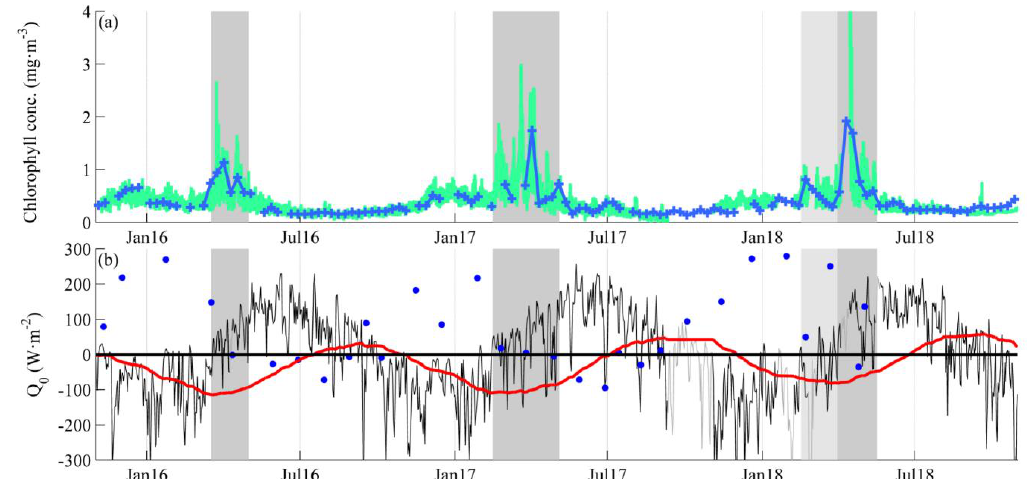
Figure 5. ( a ) Surface chlorophyll concentration derived from AGL buoy hourly fluorescence measurements at 3 m depth (green line) and from weekly satellite-derived Chlorophyll a concentration from GlobColour project (blue cross line). ( b ) Net heat flux (Q 0 ) (black line) from the ocean to the atmosphere (negative values imply a heat loss by the ocean). Gaps in Q 0 time-series estimated from AGL buoy data are filled with that obtained from NCEP / NCAR reanalysis (grey line). Blue dots show the accumulated heat storage above the mixed layer depth (MLD) (Q strg ) estimated from hydrographic profiles from SATS oceanographic station. It is shown as − Q strg to facilitate the identification of net heat loss events su ffi ciently negative to remove Q strg above the MLD (Q 0 < − Q strg ). The red curve shows the accumulated net heat flux. The grey shadow areas mark the time period each year between: (1) the initial moment in which the net heat flux becomes “e ff ectively” positive (Q 0 (black line) passes from negative to positive values and the accumulated Q 0 starts to increase) and (2) the definitive cessation of convective mixing when the last net heat loss event su ffi ciently negative to reach the base of the MLD occurs (su ffi ciently negative to remove Q strg above the MLD). In 2018, a first small peak in near-surface Chl coinciding with a short-live Q 0 > 0 event is highlighted in light grey. The largest peak occurs when Q 0 becomes “e ff ectively”